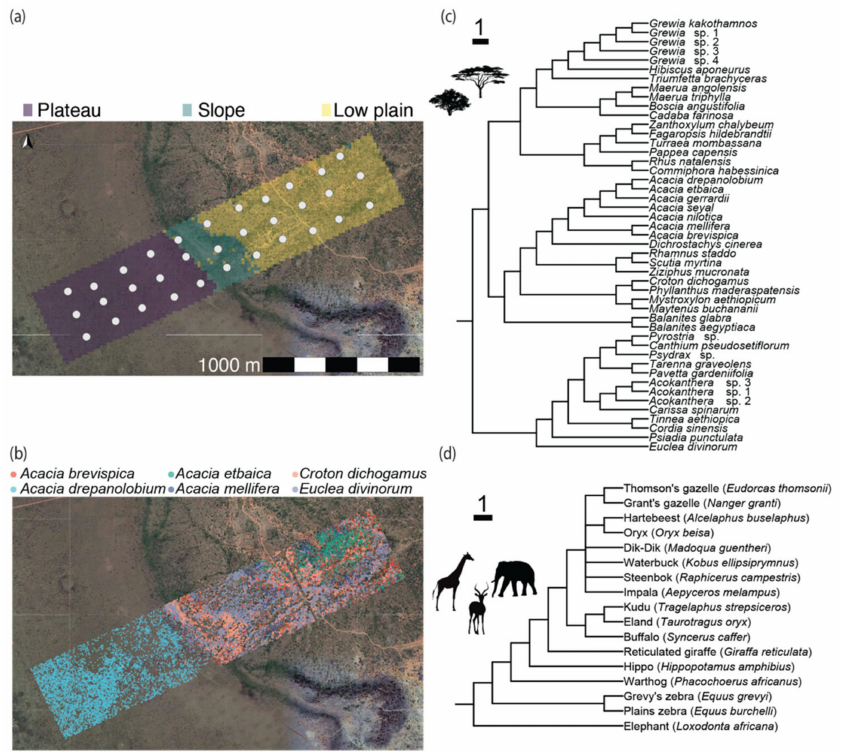
Figure 1. The Mpala ForestGEO ecosystem. ( a ) The map shows the extent of the study plot, with white circles representing 33 sampling sites. The three habitats are distinguished by color (purple = “plateau”, teal = “slope”, yellow = “low plain”). ( b ) The locations of six woody plant species comprising 80% of stems in the plot are shown with different color points. Phylogenies show relationships between ( c ) woody plants and ( d ) large mammalian herbivores; scale bars represent 1 MY. Note Hibiscus aponeurus in the phylogeny represents Hibiscus spp. in the ForestGEO data; see Table S1 in Supplementary Materials for description of grafted or substituted